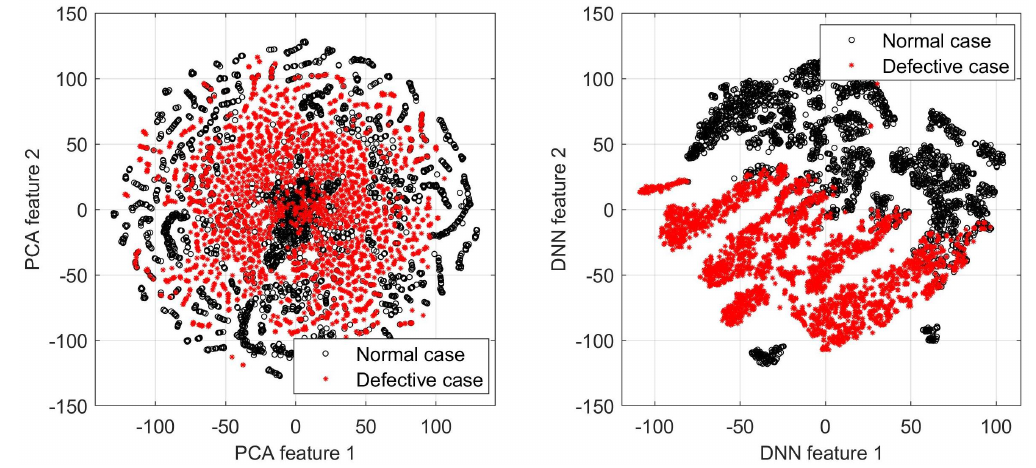
Figure 11. Comparison of the feature space established by raw image and convolutional neural network